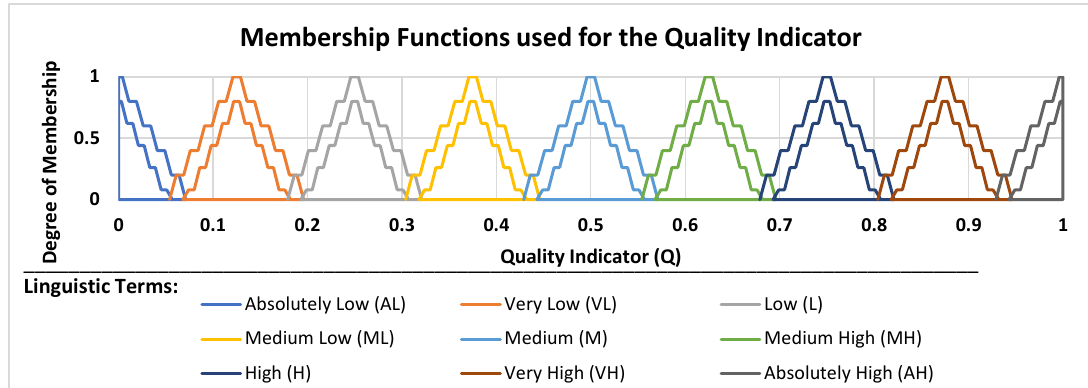
Figure 4. The membership functions used for the representation of the SINR indicator.